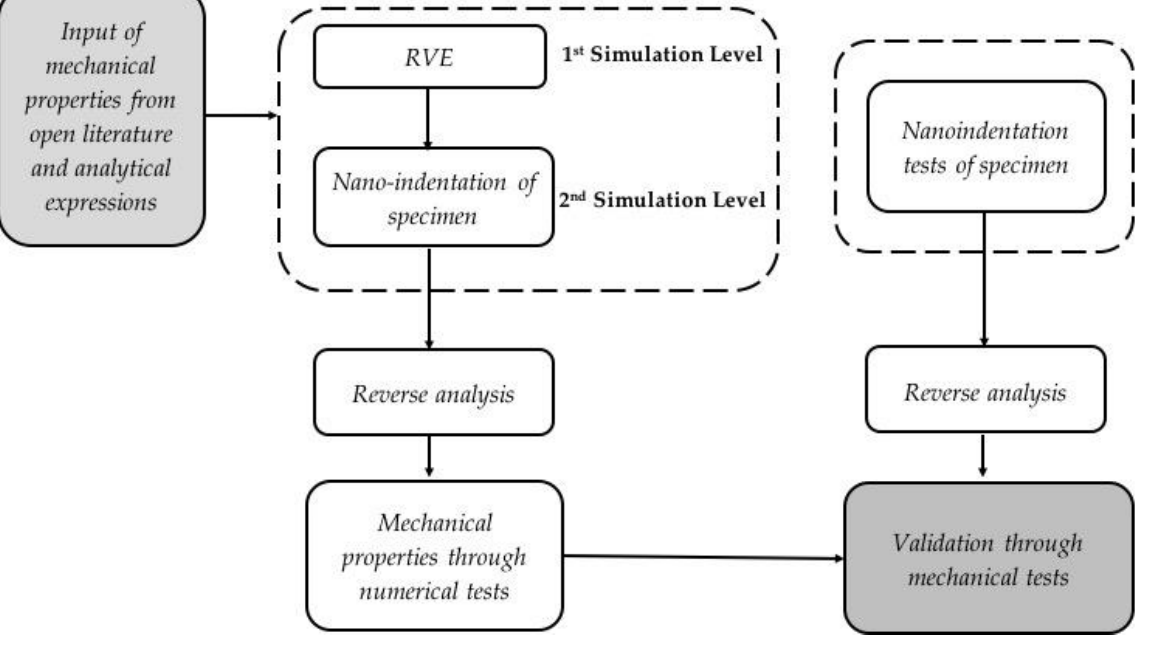
Figure 3. Flowchart of the methodology.